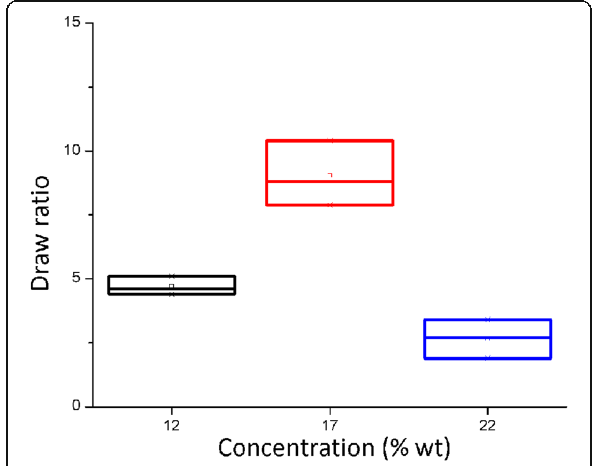
Fig. 4 Draw ratio of the electrospinning sol – gel